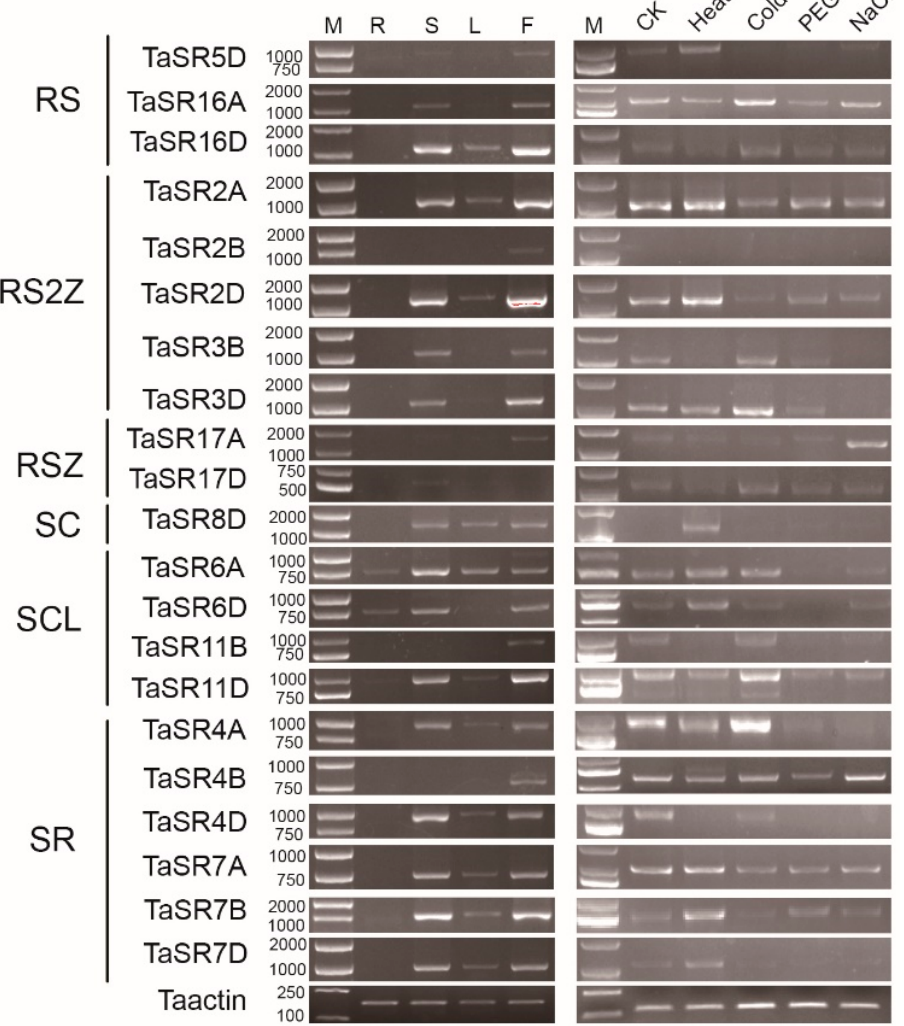
Figure 6. Expression pattern of TaSR protein genes. M, R, S, L, and F indicate DL2000 marker, root, stem, leaf, and inflorescences in plants. CK (H 2 O), Heat, Cold, PEG, and NaCl represent different abiotic stresses.